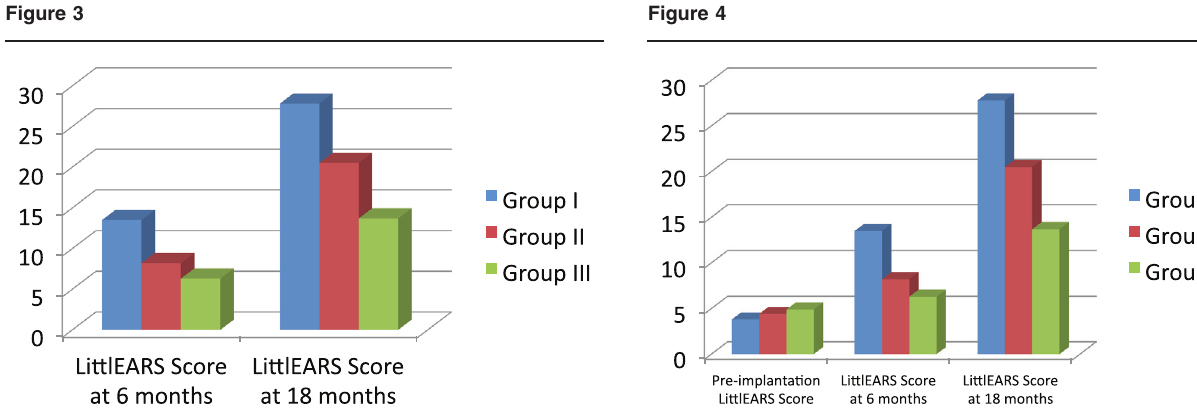
Individual comparisons between the 6- and 18-month scores of LittlEARS Auditory Questionnaire in the three groups.